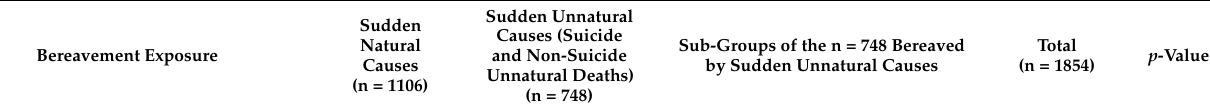
Table 1. Sociodemographic and clinical characteristics of bereaved